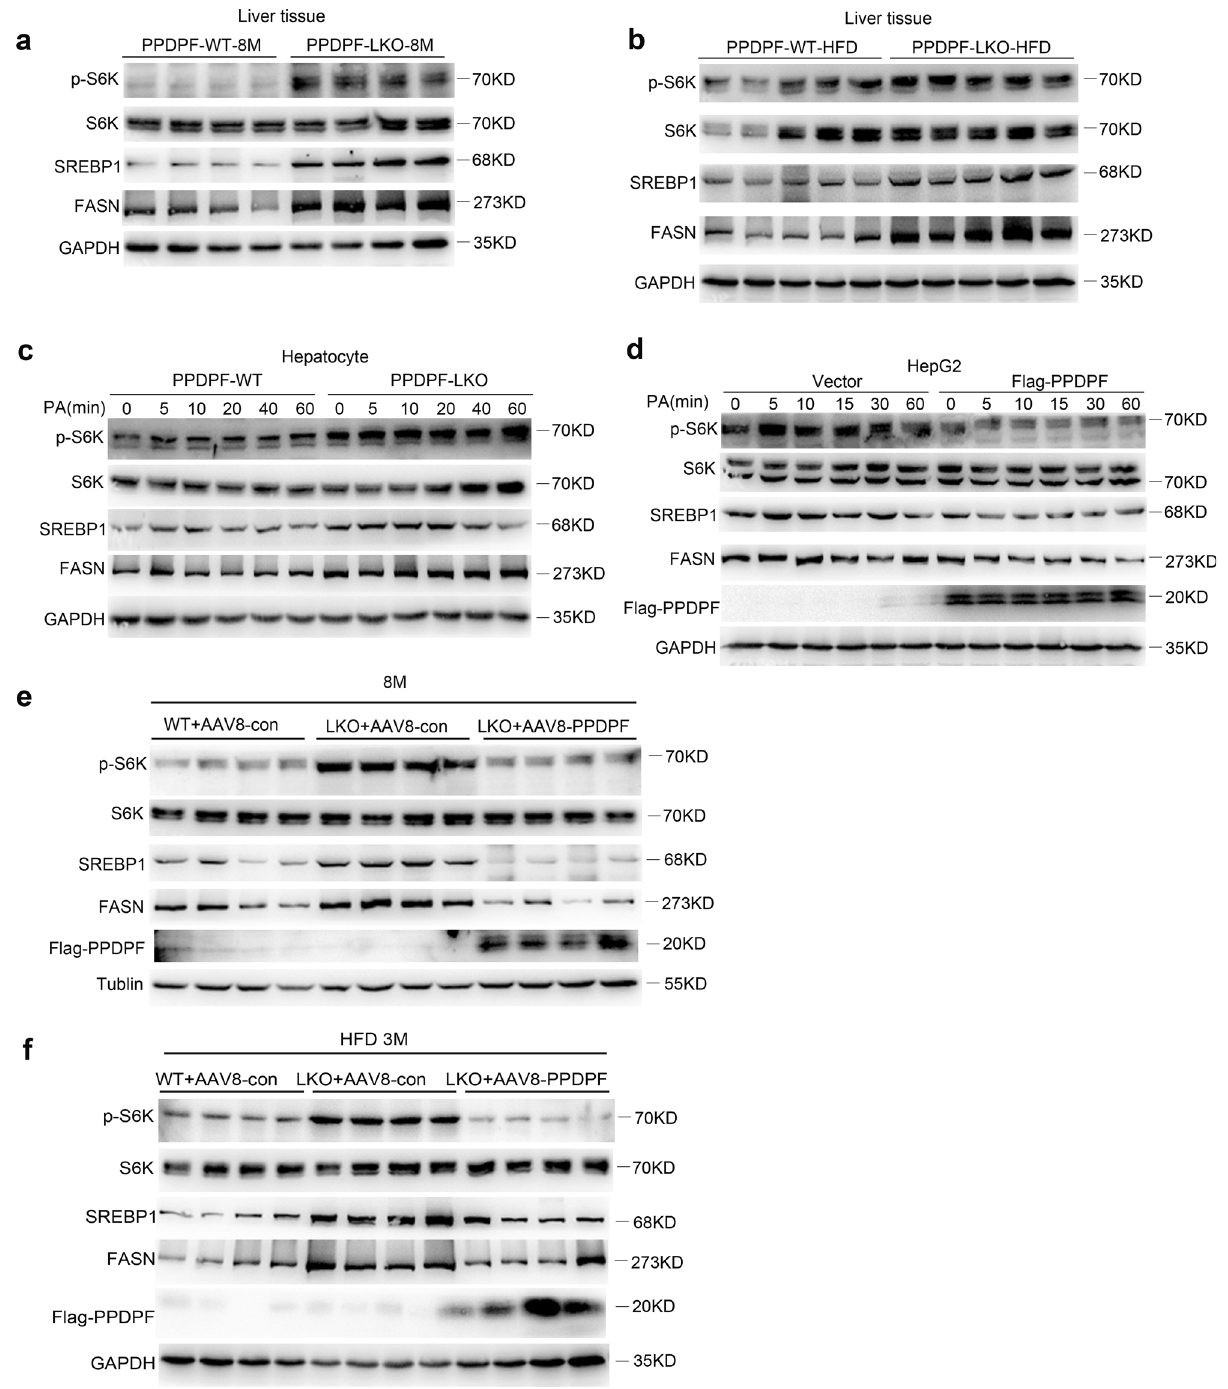
Fig. 4 PPDPF represses mTOR signaling pathway during the development of hepatic steatosis. Western blot analysis of phosphorylated S6K, total S6K, cleaved-SREBP1, and FASN in the livers from NC ( a ) ( n = 4 per group) or HFD ( b ) ( n = 5 per group) fed mice in PPDPF-WT and PPDPF-LKO groups. Western blot analysis of phosphorylated S6K, total S6K, cleaved-SREBP1, and FASN in primary hepatocytes ( c ) and HepG2 ( d ) cells upon PA treatment. e Expression of p-S6K, S6K, SREBP1 and FASN in liver samples of WT + AAV8-con, LKO + AAV8-con and LKO + AAV8-PPDPF mice in rescue experiment ( n = 4 per group). f Expression of p-S6K, S6K, SREBP1, and FASN in liver samples of WT + AAV8-con, LKO + AAV8-con and LKO + AAV8-PPDPF mice in rescue experiment after 3-month HFD feeding ( n = 4 per group). All experiments were repeated three times